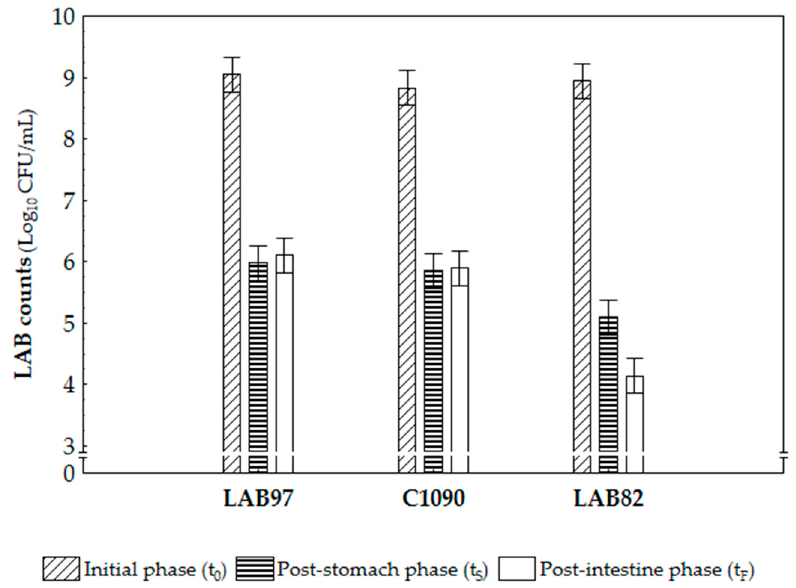
Figure 1. The LAB counts (log 10 CFU/mL) for the LAB97, C1090, and LAB82 (as reference) strains under in-vitro-simulated gastrointestinal conditions. Bars represent the confidence intervals at 95%.